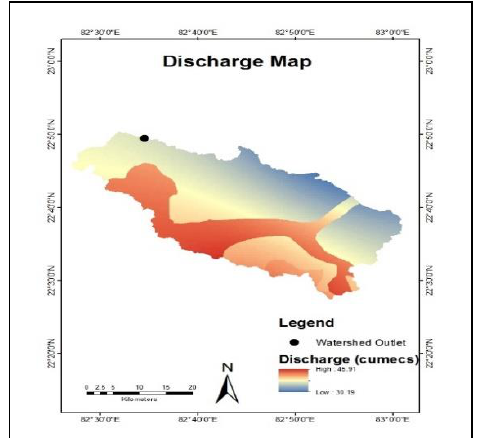
Figure8. Watershed discharge map.